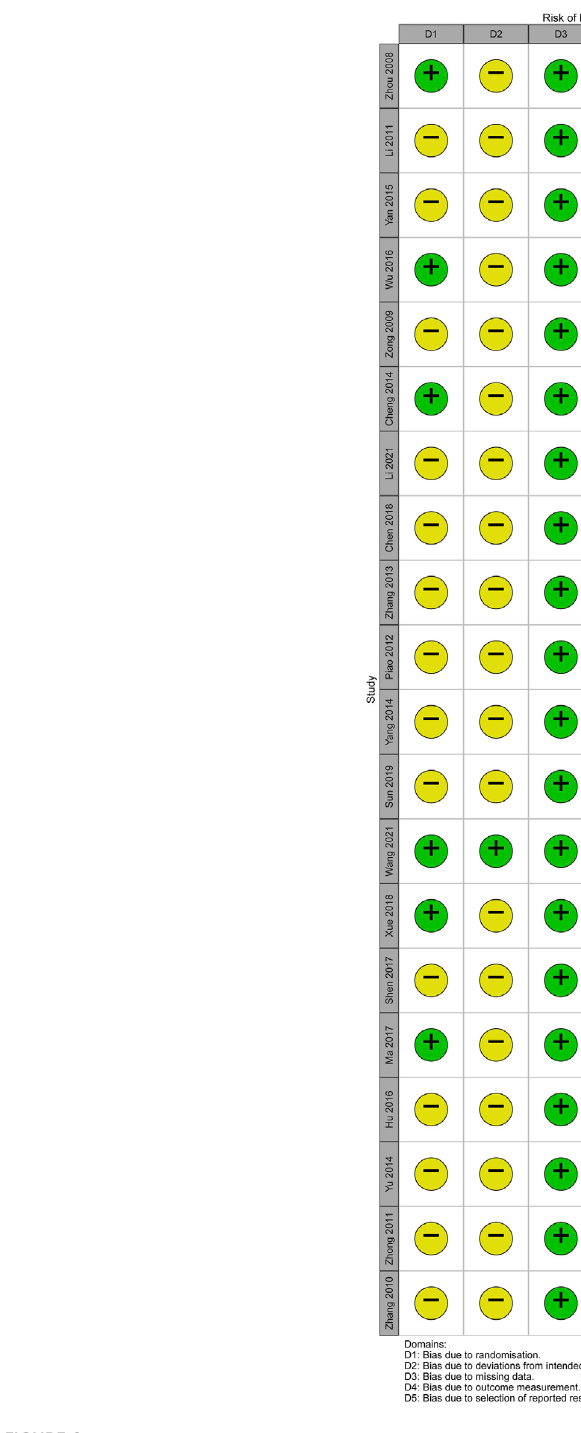
FIGURE 2 Risk of bias